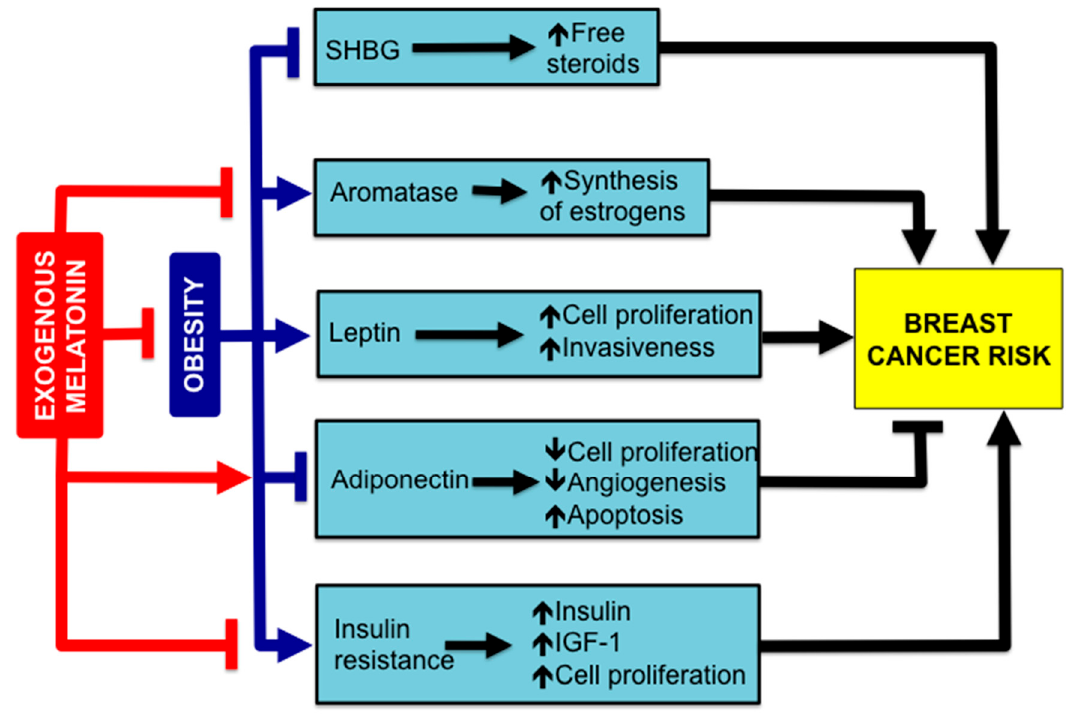
Figure 5. The increased breast cancer risk associated with obesity is related to factors such as: a low concentration of sex hormone-binding globulin (SHBG), which increases the bioavailability of sex steroids; an enhanced expression of aromatase, and the subsequent increase of local synthesis of estrogens; an elevated secretion of leptin by white adipose tissue (WAT) that stimulates cell proliferation; a low concentration of adiponectin, an adipokine that inhibits cell proliferation and angiogenesis and induces apoptosis; the development of insulin resistance, with an elevated insulin blood concentration which induces the release of growth factors (IGF-1), stimulating cell proliferation. Melatonin, stimulates adiponectin secretion; inhibits aromatase expression and prevents insulin resistance. Furthermore, melatonin reduces body weight gain, diminishing obesity.